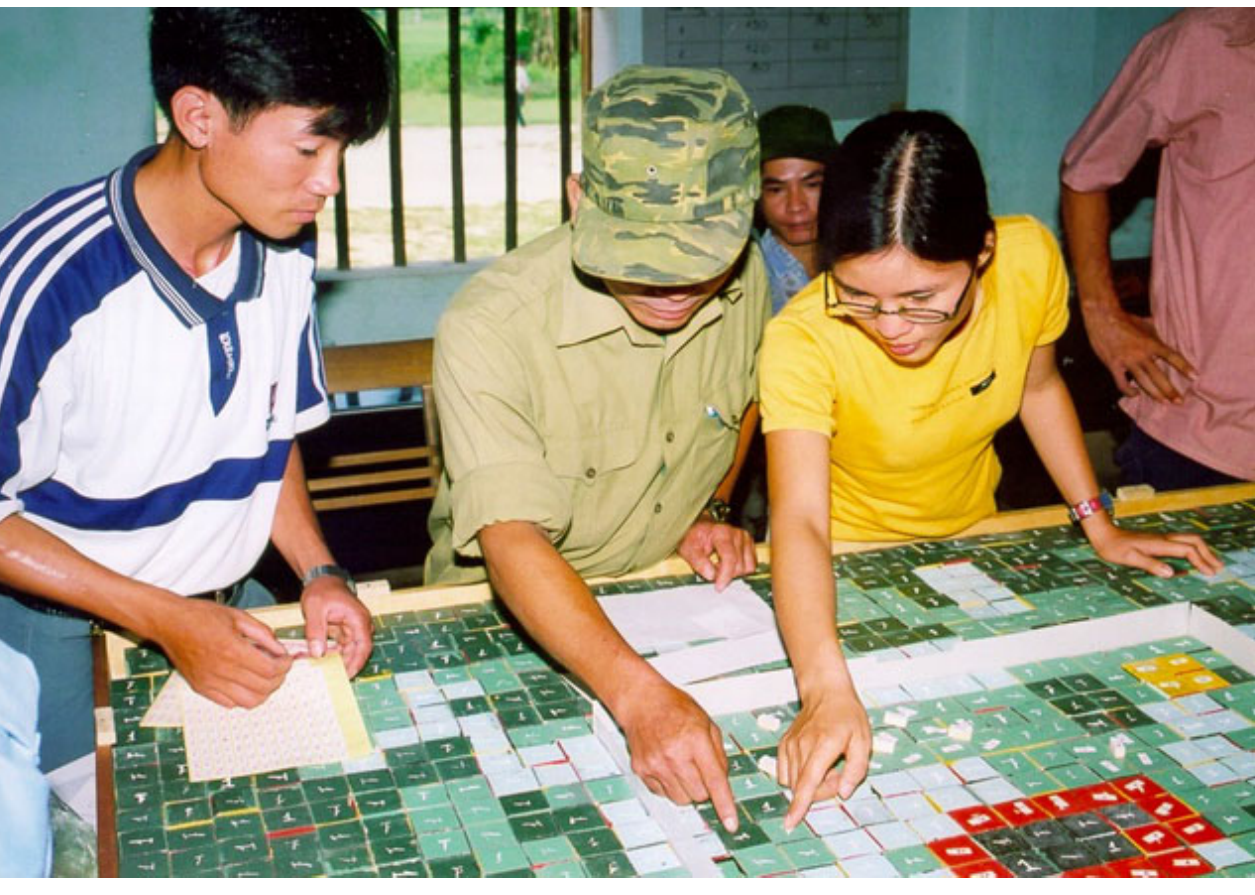
Fig. 2. The game board used for the SAMBA role-play. (Photograph by J. C.